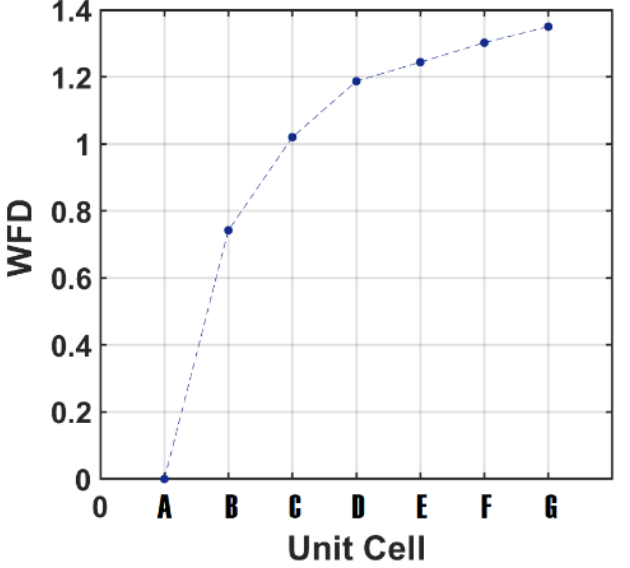
Figure 8. The working frequency duration (WFD) vs the number of RR antennas for different unit cells from A to G .